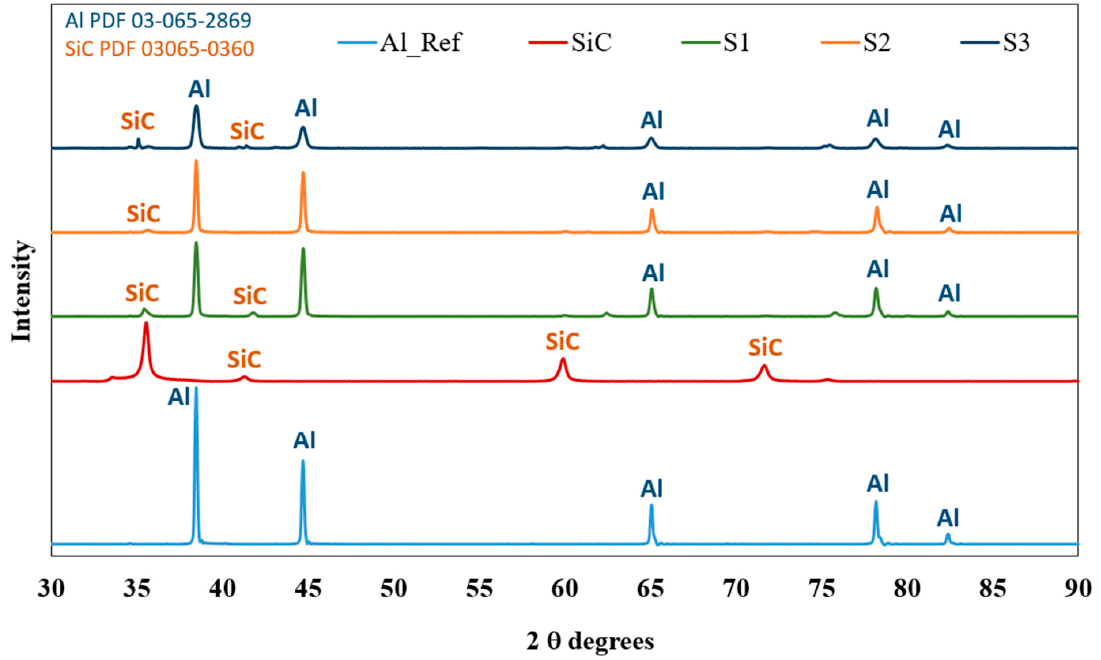
Table 2. Measurements and densities of bulk composites.